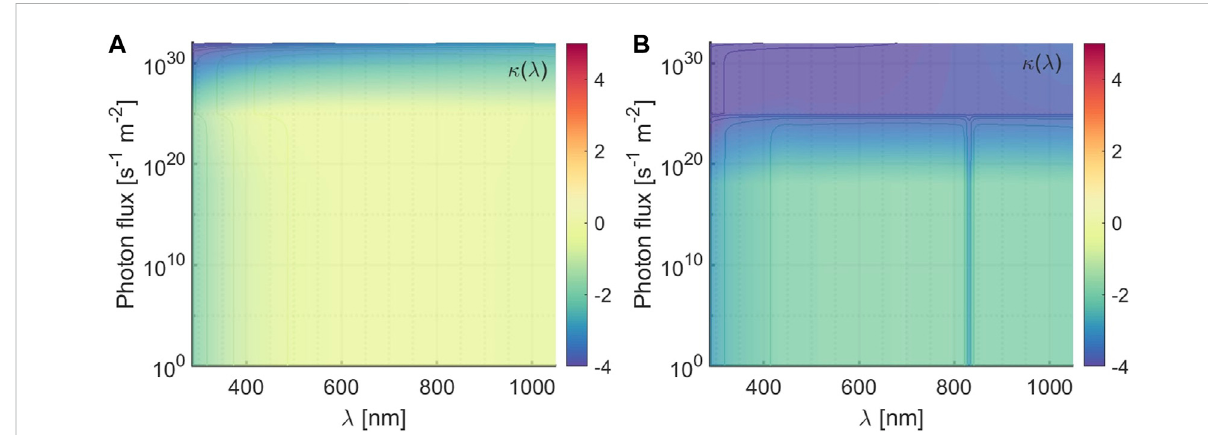
FIGURE 10 Numerical opacity κ ( λ ) [cm 2 g − 1 ] (log scale) of argon plasma in the VIS range, as resulting from NLTE CR calculations in FLYCHK, at electron density ρ e = 1.4 · 10 17 m − 3 , and energy of (A) k B T e = 2.43 eV, and (B) k B T e = 7.88 eV. Opacity is shown in the wavelength λ [nm] - external radiation photon fl ux s − 1 m − 2 plane. Plasma parameters of (A) have been selected from OES data from cfg. 7, at P RF = 120 W (see Table 4), while for (B) the density has been maintained equal and the energy increased.